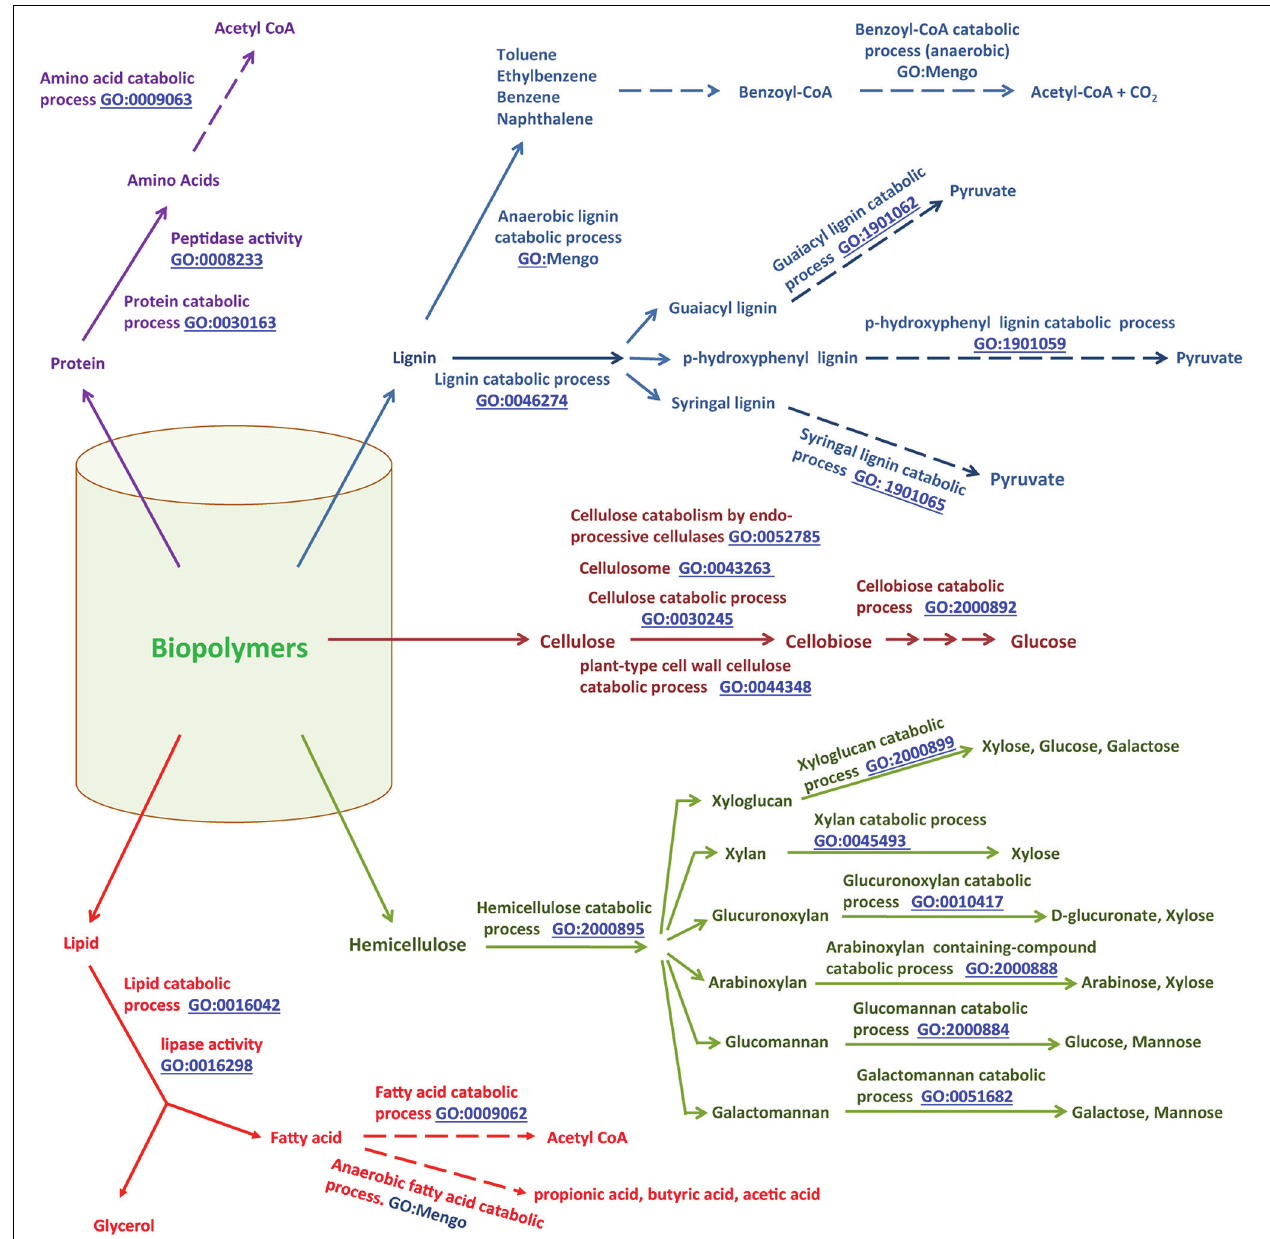
FIGURE 3 | General pathways for biopolymer degradation, and relevant GO terms. Biopolymers such as cellulose, hemicellulose, lipids, proteins and lignin are converted to their respective monomers/oligomers. Monomers are further catabolized to simple compounds which then can be metabolized by